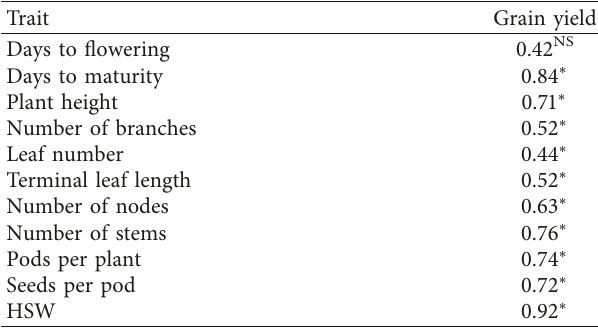
Table 6: Correlation of selected agronomic traits with grain yield. Trait